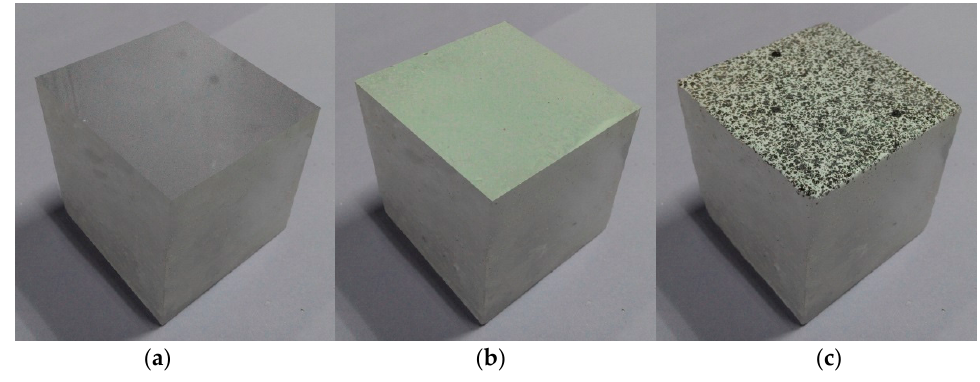
Figure 3. Three types of ice specimens: ( a ) Non-speckle specimen (transparent specimen); ( b ) pure-white specimen; and ( c ) white-black speckle specimen. All of them are cubes with an edge length of 5 cm.